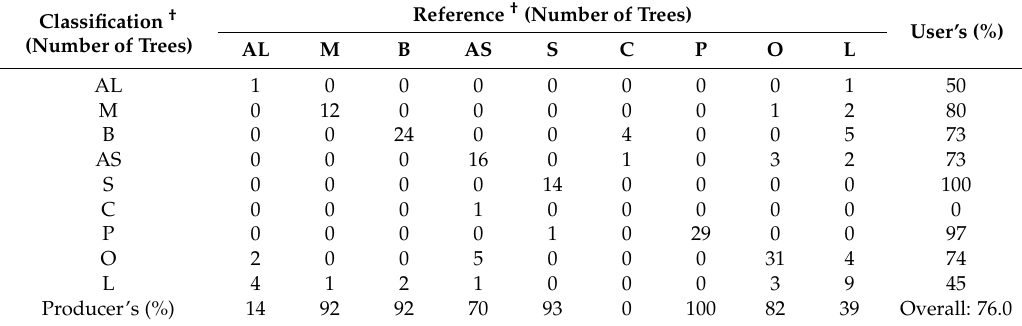
C 1 , Q C 1 , Q C 2 , Q C 2 , Q C 3 and Q C 3 05 90 95 90 01